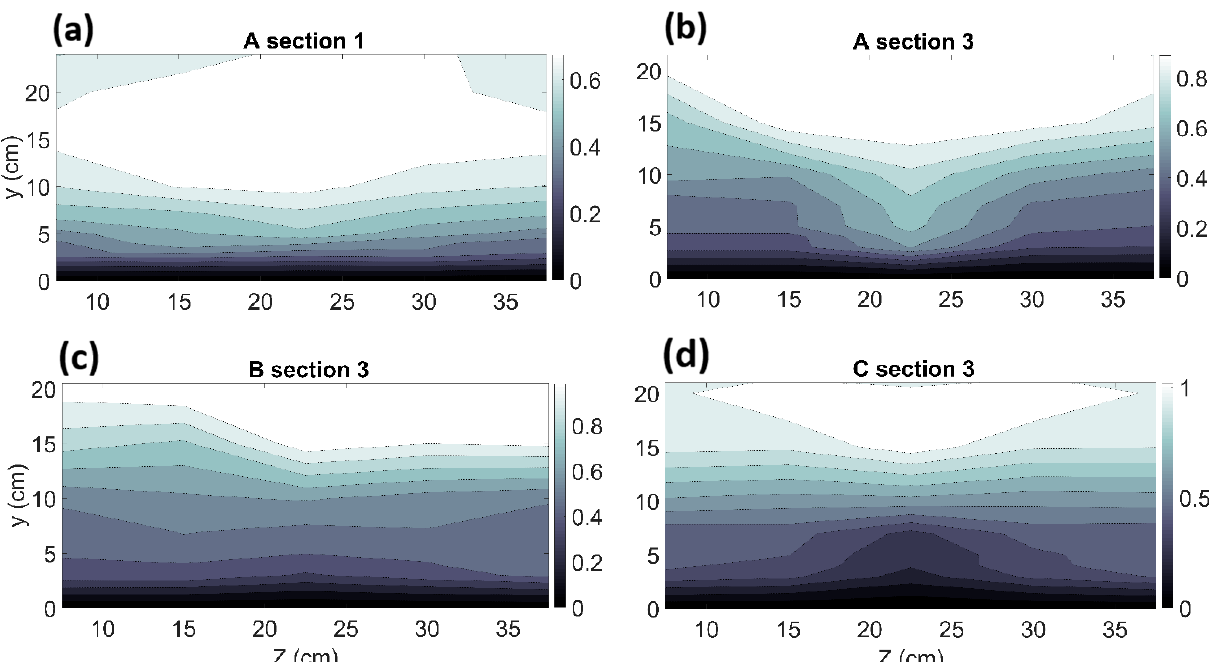
Figure 5. Velocity contours on the z-y plane for ( a ) case A section 1, ( b ) case A section 3, ( c ) case B section 3, ( d ) case C section 3.